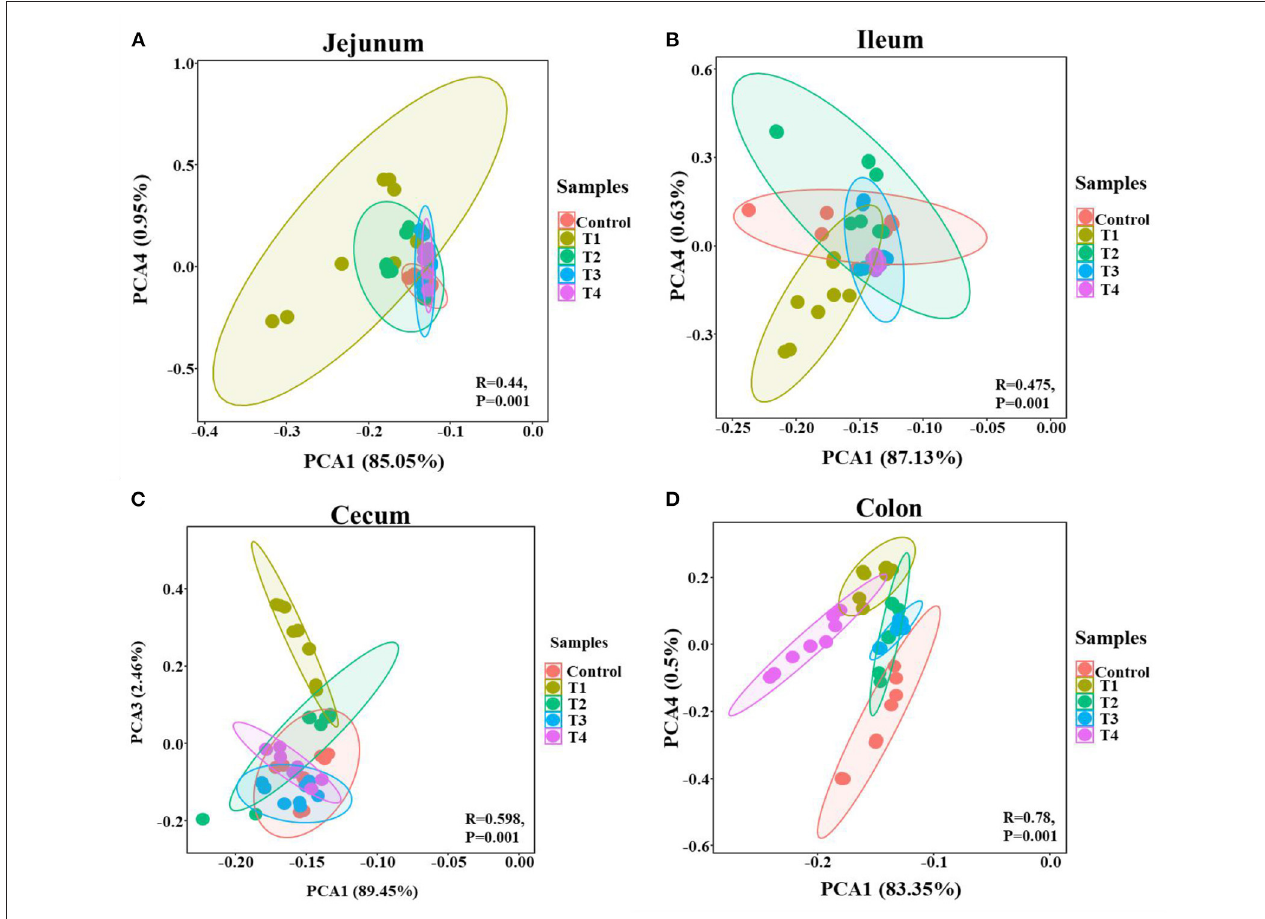
FIGURE 3 | PCA of the mice gut microbial community composition of the Control and T1-4 group based on the Bray-Curtis distances showed distinct clusters, P -value and R -value were calculated by ANOSIM. The jejunum (A) , ileum (B) , cecum (C), and colon (D) microbial community structure between the Control group and T1–4 groups were differentiated by colors (red, brown, green, blue, purple,